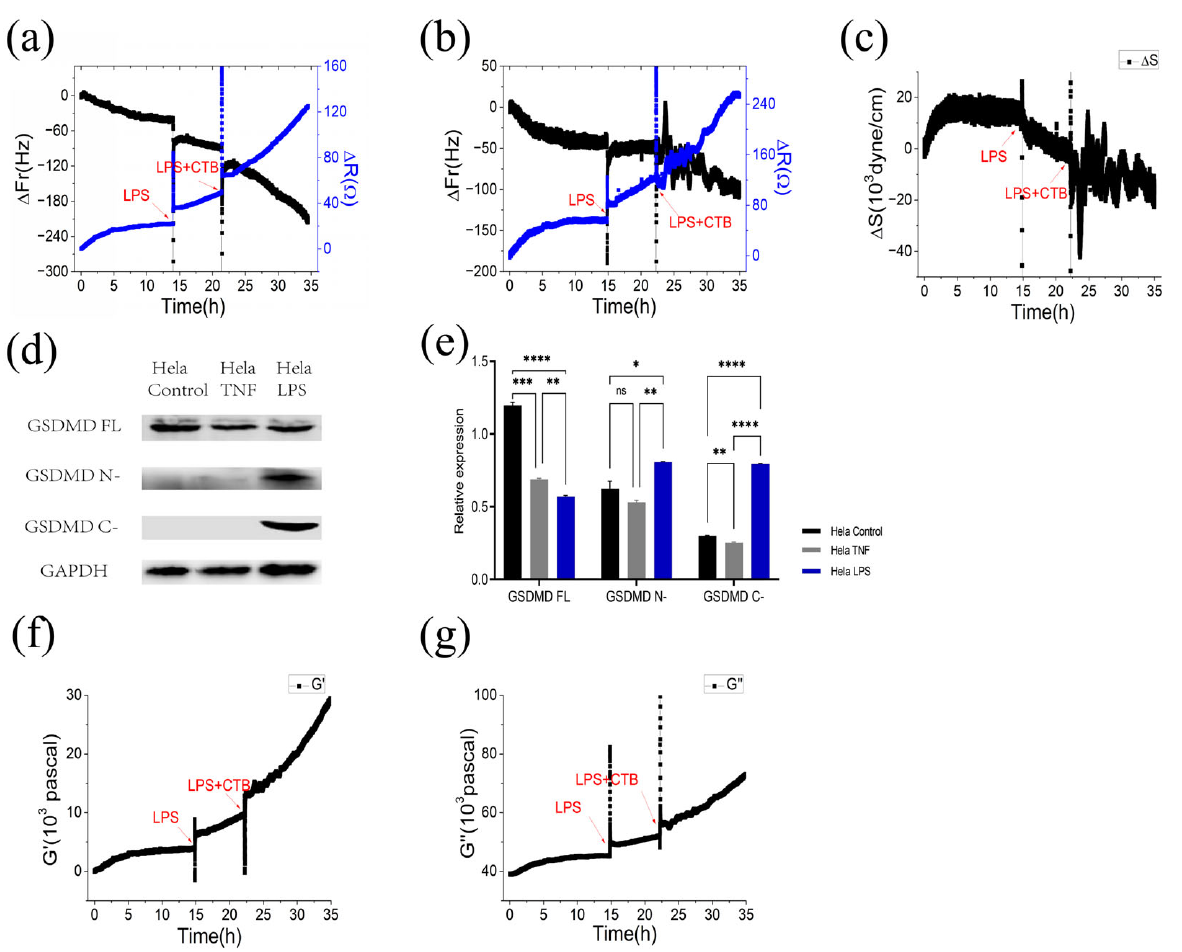
Figure 1. Dynamic QCM responses and cytomechanical parameters recorded during LPS and CTB induced pyroptosis in 2000 HeLa cells. ( a , b ) Frequency shifts and motional resistance changes on AT ( a ) and BT ( b ) cut quartz crystal; ( c ) Cells generated force on quartz crystal; ( d ) Effects of